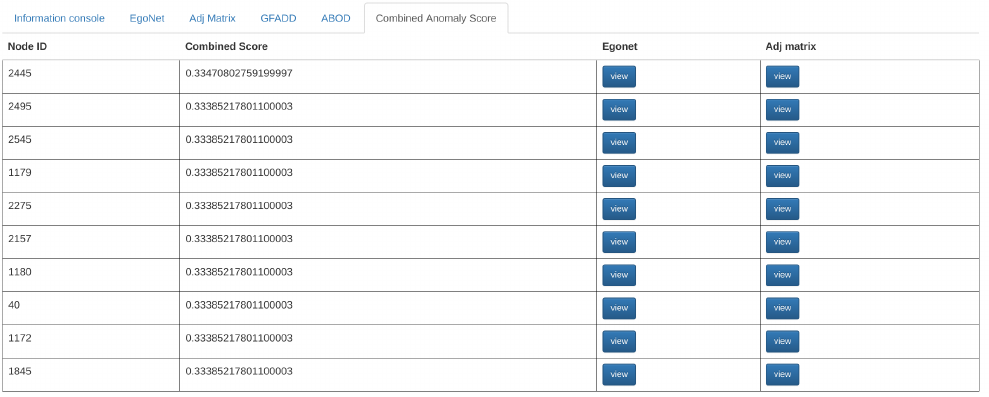
Figure 8. Layout of the anomaly scores